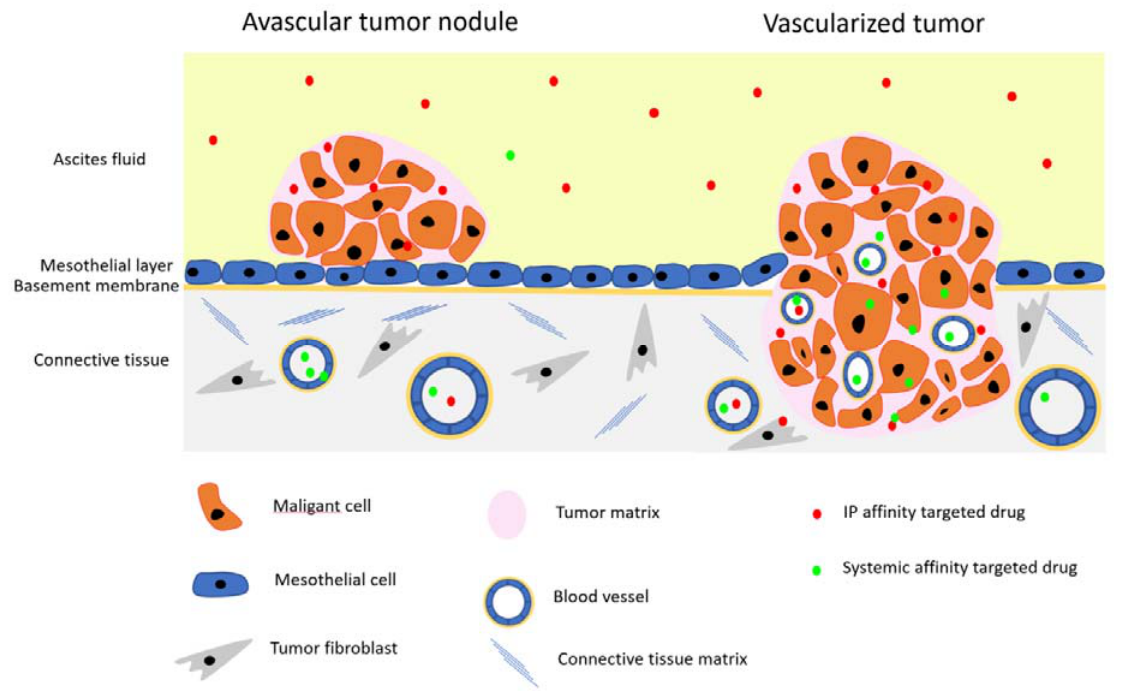
Figure 1. Intraperitoneal (IP) versus systemic targeting of peritoneal carcinomatosis (PC). IP-administered affinity targeted drugs are recruited and penetrate tumors directly and through systemic circulation, whereas intravenous (IV) drugs rely on systemic transport. IP delivery route has the advantage of targeting small avascular tumor nodules left behind after surgery.